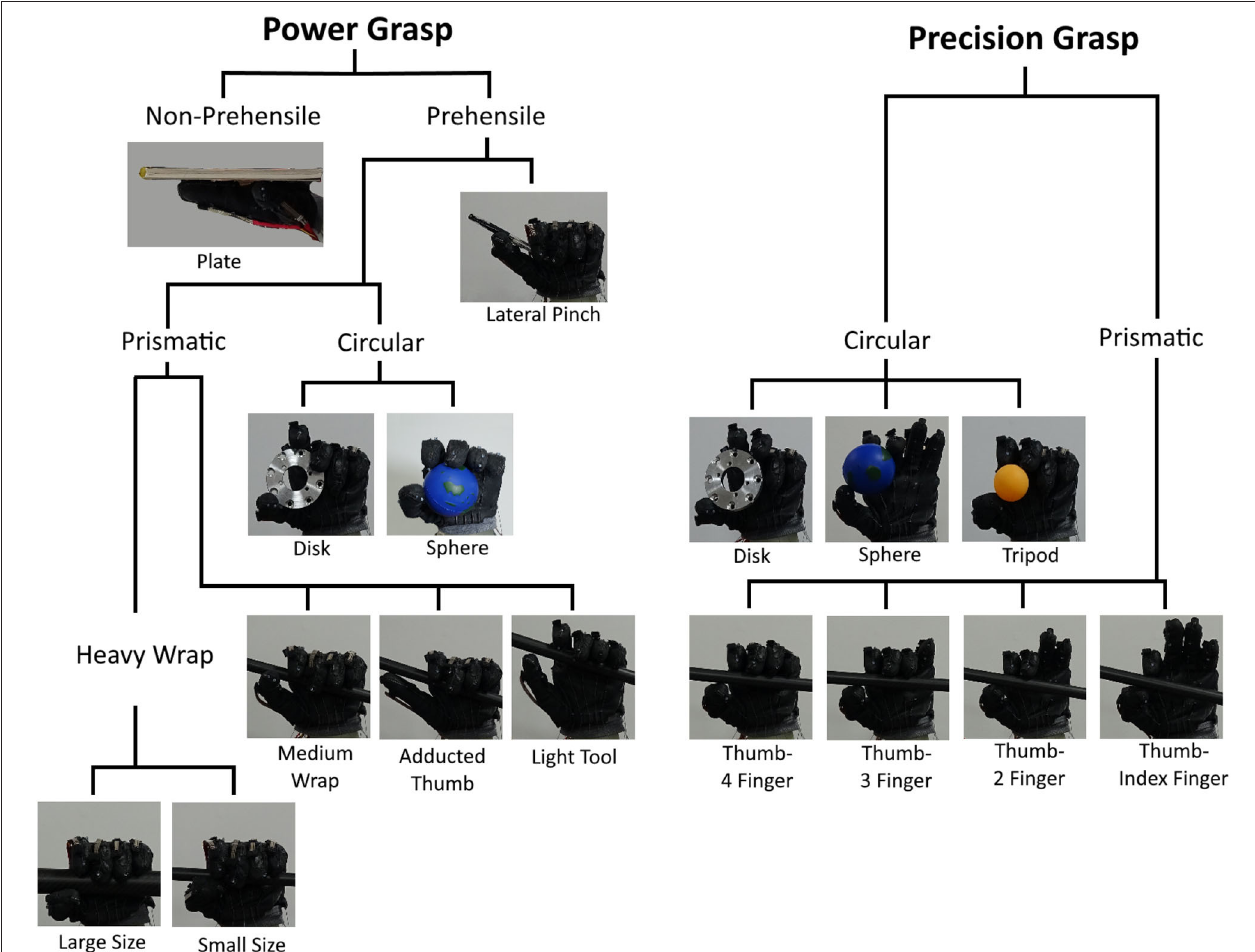
FIGURE 9 | The hand poses realized by our robotic hand, according to the Cutkosky taxonomy. The hand was able to realize all 16 poses proposed by the taxonomy.